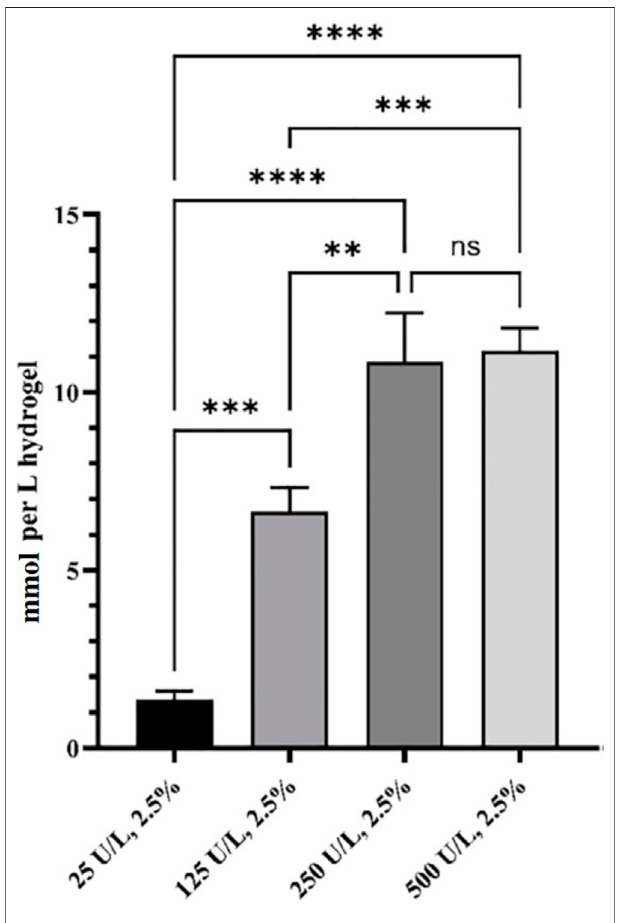
FIGURE 4 | Released H 2 O 2 from HB PEGDA/HA-SH 10.0 – 1.0 hydrogels containing 2.5% w/w G and different amounts of GO (0 – 500 U/L), expressed as mmol/L of hydrogel. Release data were obtained under static conditions over 24 h ( n (cid:2) 4). (** indicates p value (cid:2) 0.013; *** indicates p value (cid:2) 0.0008; **** indicates p value < 0.0001).